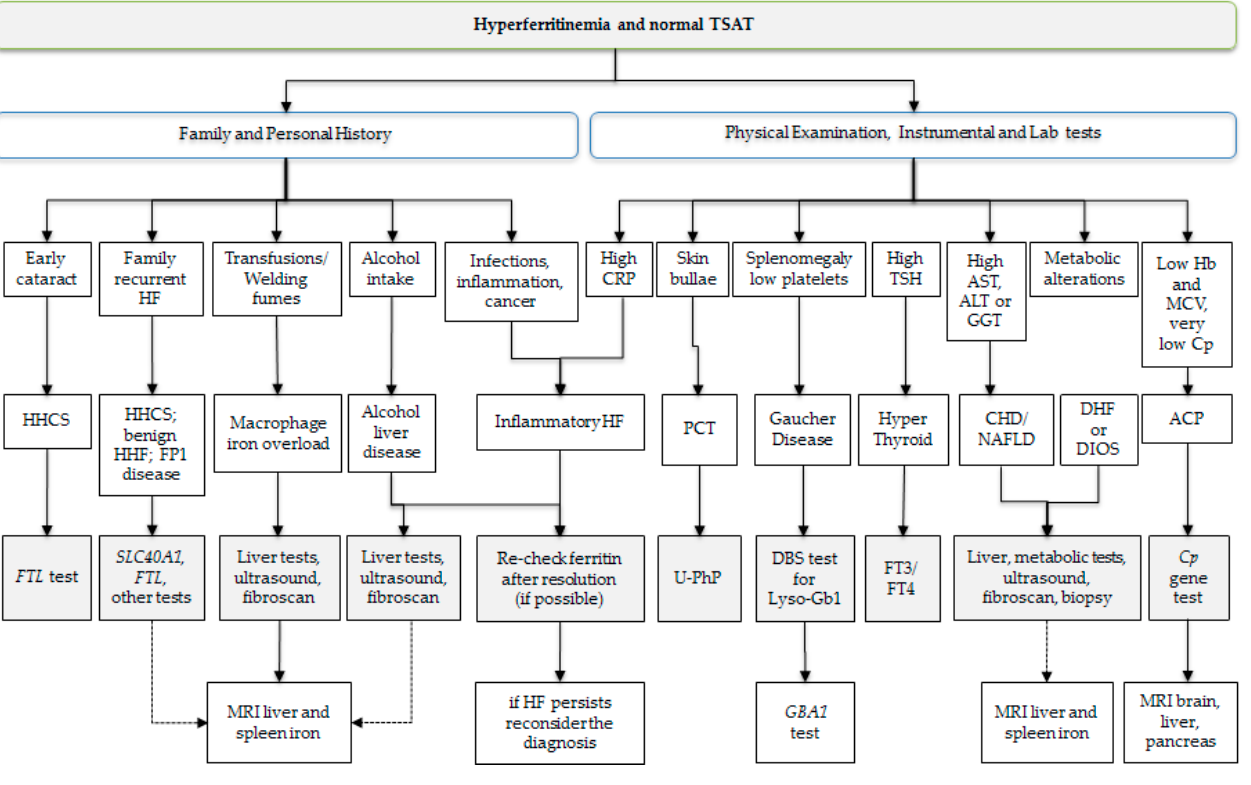
Figure 2. Flow-chart of isolated hyperferritinemia. In the first step, information on patient and family history, clinical symptoms, and laboratory tests can be used to hypothesize or exclude some causes of hyperferritinemia and propose other laboratory or instrumental tests to further proceed in the step-by-step differential diagnosis. The second step shows the hypothetical diagnosis that should be confirmed or supported by more specific biochemical, genetic, and instrumental tests. Genetic tests can be performed to confirm the suspect of HHCS in case of a personal and family history of early cataract or hyperferritinemia, aceruloplasminemia in case of absent or very low level of serum ceruloplasmin, Gaucher disease in case of positive DBA test for LysoGb1, and ferroportin disease in case of recurrent hyperferritinemia with dominant transmission. Liver ultrasound